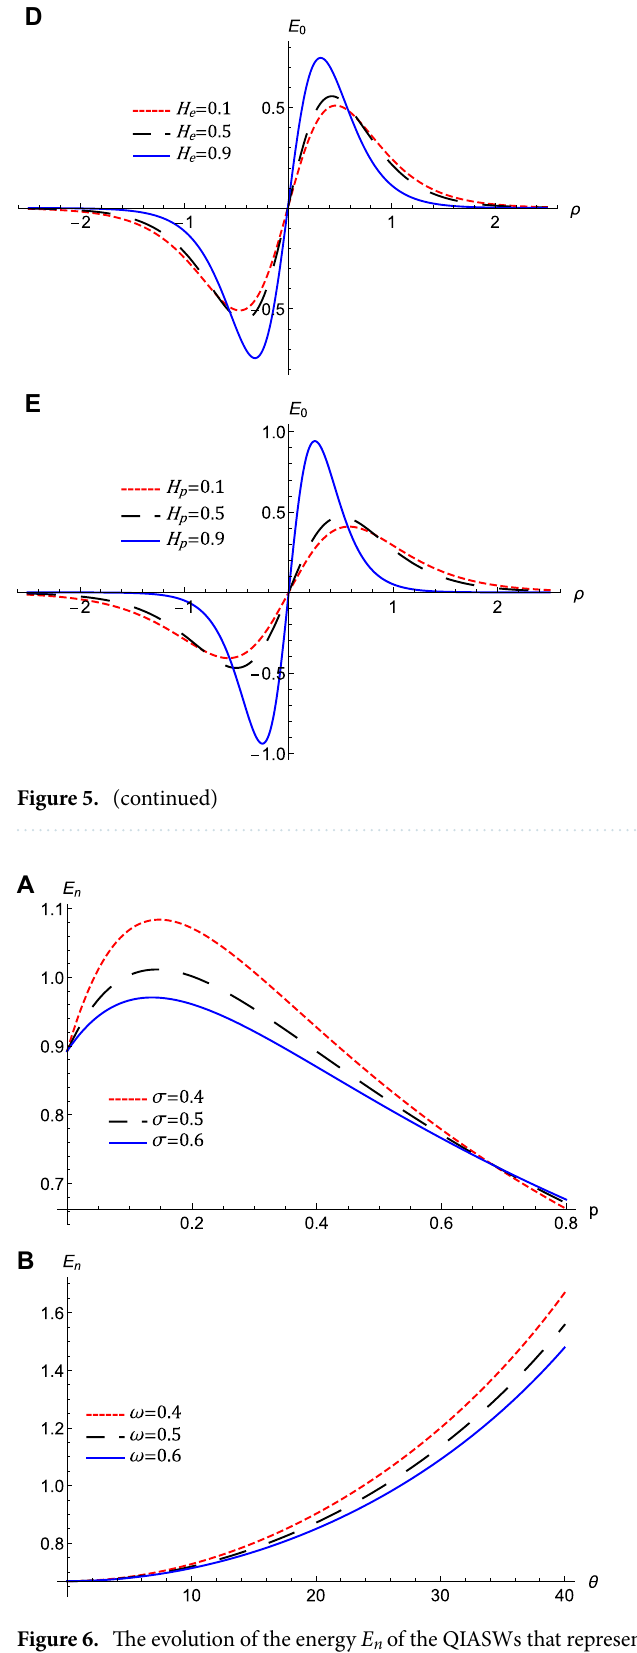
Figure 6. The evolution of the energy E n of the QIASWs that represented by equation ( 19 ) at M = 0.4 , H e = 0.4 , and H p = 0.6 , ( A ) against p for different values of σ at ω = 0.5 , θ = 20 , ( B ) against θ for different values of ω at σ = 0.5 , p = 0.7